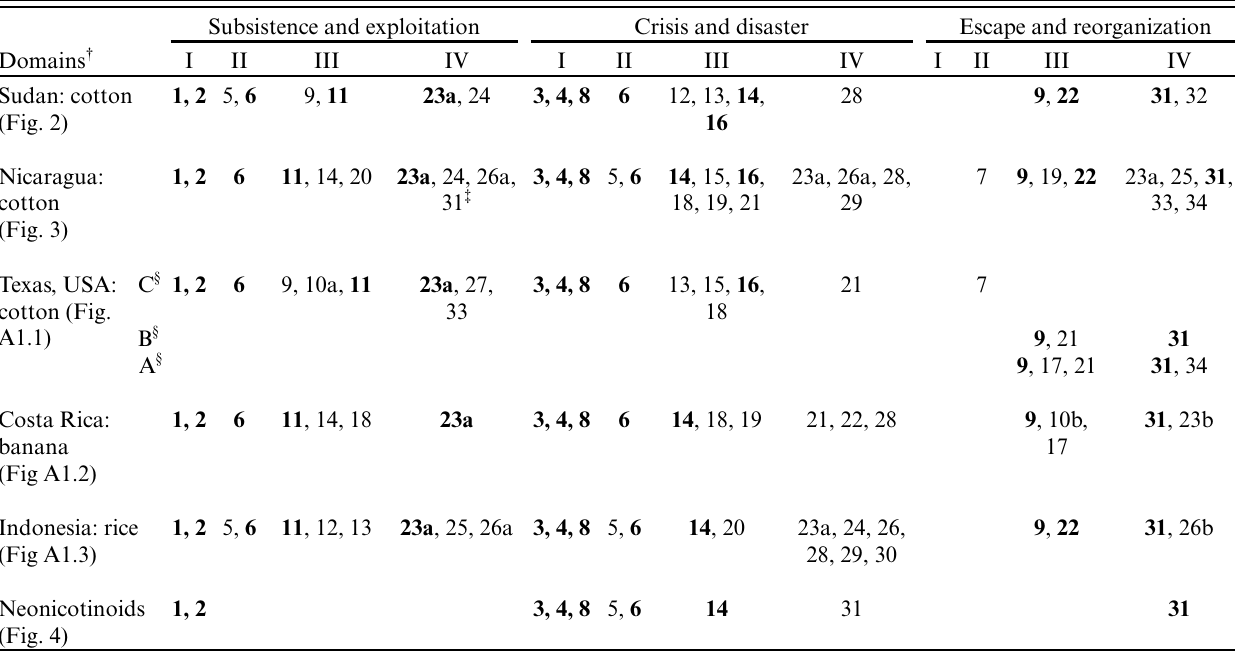
Table 1 . Overview of (enabling and disabling) drivers in the three phases of the pesticide treadmill. Drivers are numbered and allocated to the four domains (I-IV) of the theoretical framework. Common drivers are indicated in bold. Subsistence and exploitation Crisis and